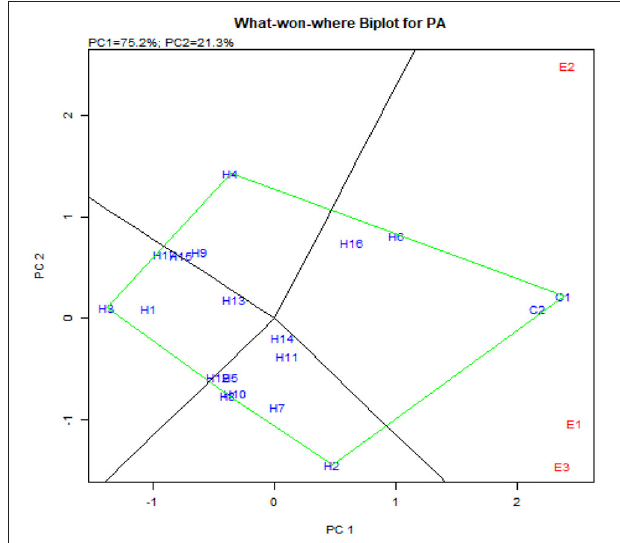
FIGURE 6 | GGE biplot for PA in hybrids. (A) The genotype view of the hybrids in the GGE plot. (B) The ideal genotype plot for hybrids in the GGE biplot.